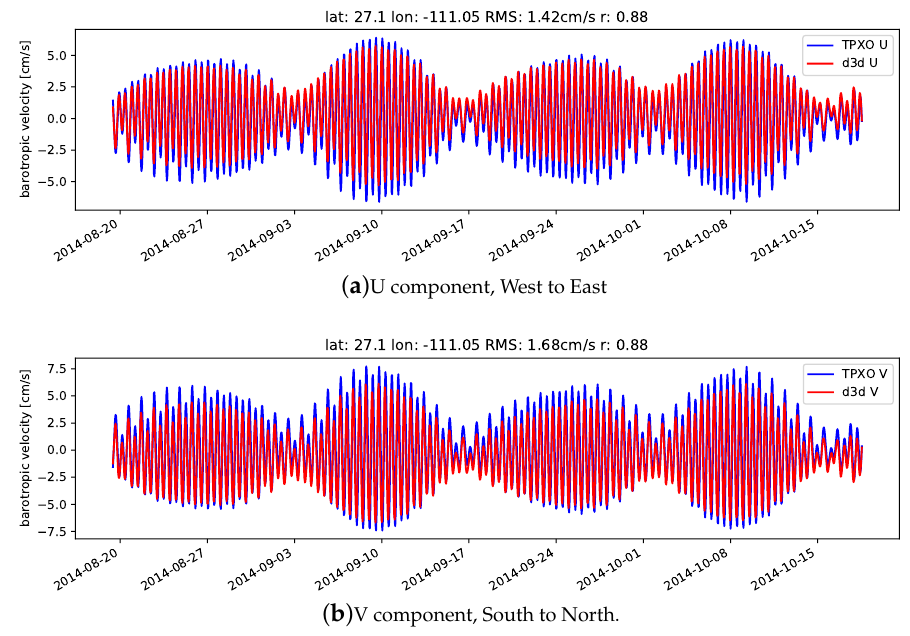
Figure 9. Time-series of components of the barotropic current at latitude 27.1 N, longitude—111.05 E. The delf3D (d3d) components have been depth-averaged for comparison. All dates in